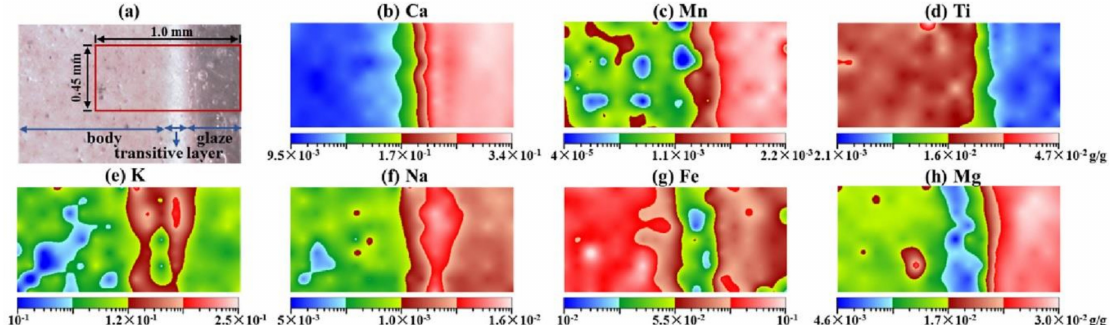
Figure 15. ( a ) Photograph of the cross-section of Yaozhou celadon. The elemental imaging in the area (1.0 mm × 0.45 mm) marked by red lines for ( b ) Ca, ( c ) Mn, ( d ) Ti, ( e ) K,( f ) Na, ( g ) Fe, and ( h ) Mg. (For interpretation of the references to colour in this figure legend, the reader is referred to the web version of the article.) Reprinted with permission from